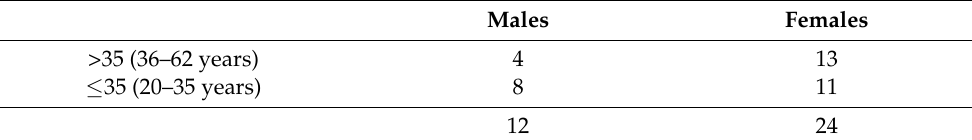
Table 1. Corpus of Conversational Santiago Spanish: participant distribution by age group and gender.